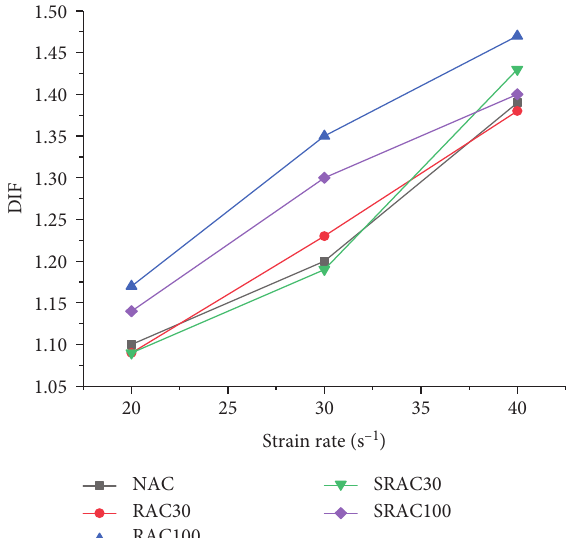
Figure 6: Peak strain of concrete specimens under different strain